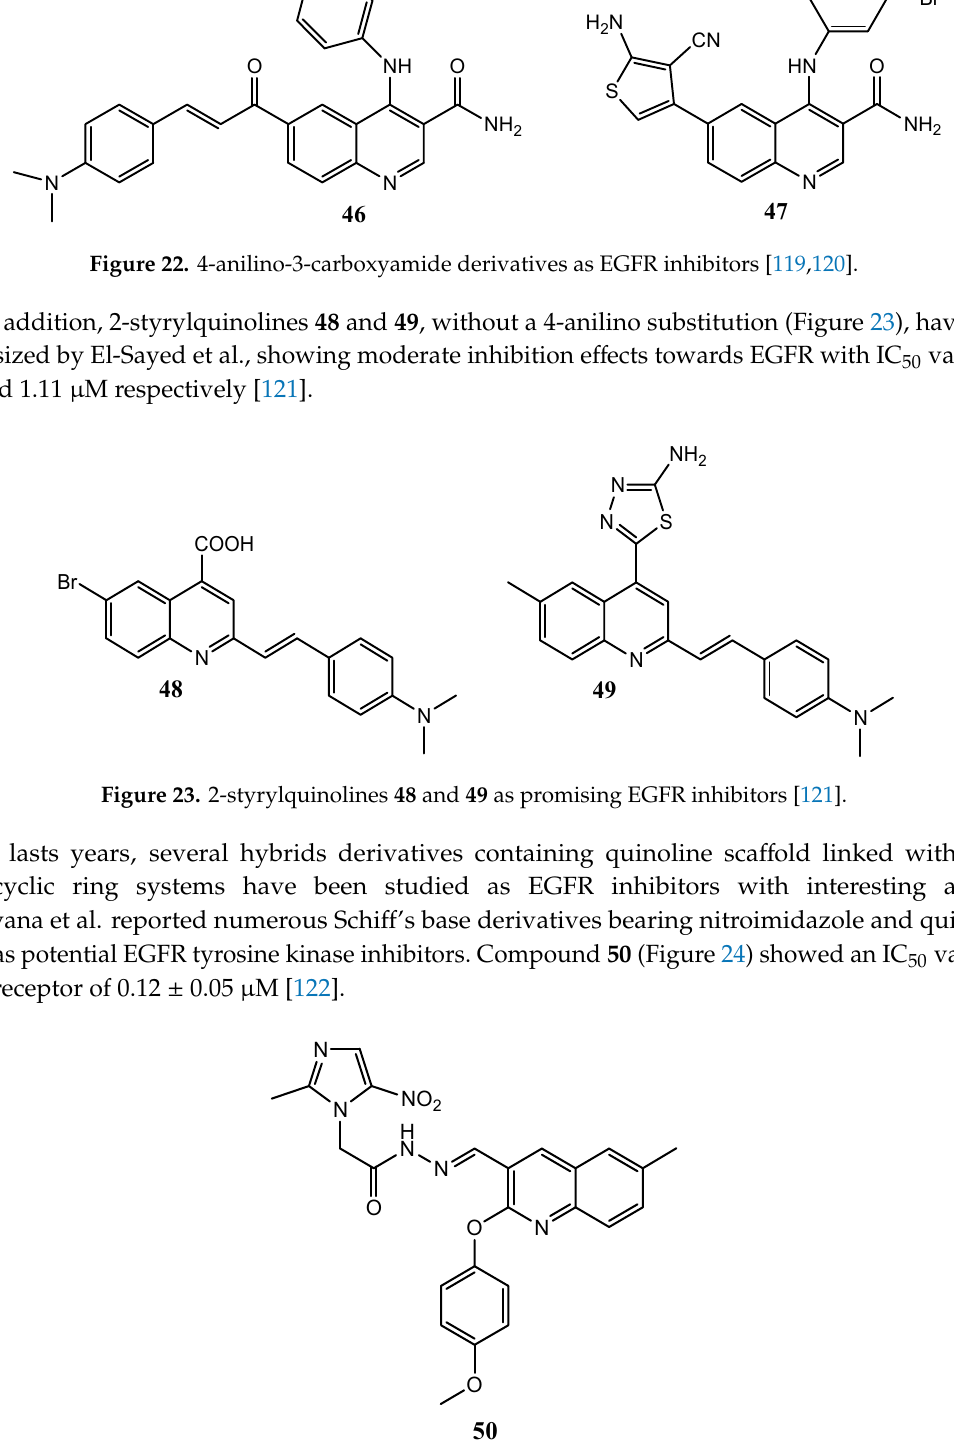
Figure 21. Structure of 4-(2-aryl-cyclopropylamino)-quinoline-3-carbonitrile as selective inhibitor of EGFR [118].